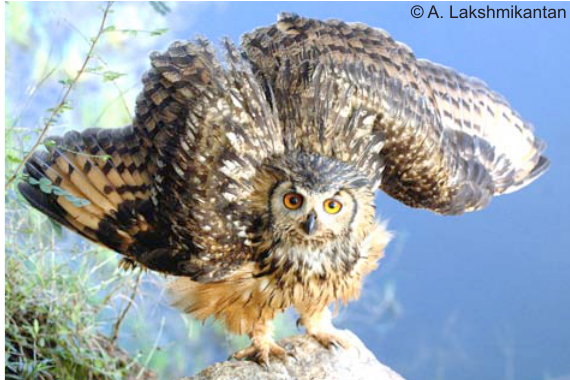
Image 7. Transition agonistic display. Note that the wings are neither parallel nor perpendicular to the ground (Human distance from the nest ca. 10-24 m).